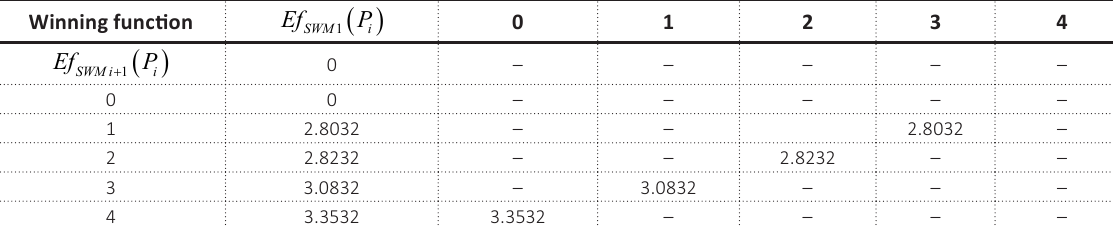
Note: *Forecast estimations (authors’ research). Table 5. Calculation of the maximum payoff in the first variant Winning